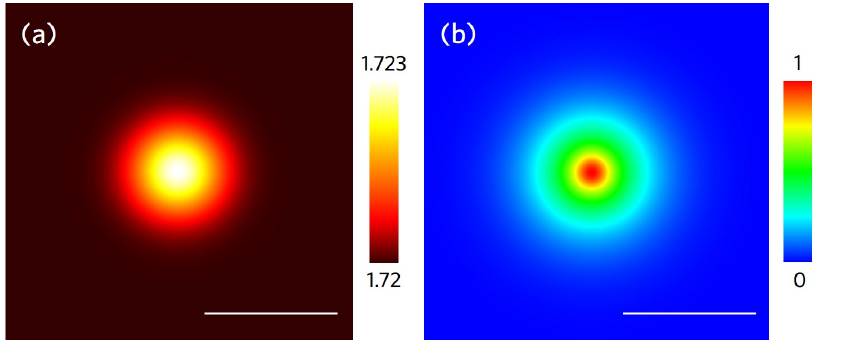
Figure 4. ( a ) Reconstructed refractive index distribution and ( b ) the corresponding modal profile of PBW fabricated Nd:YCOB buried waveguide (WG2). Both scale bars denote 5 μ m.